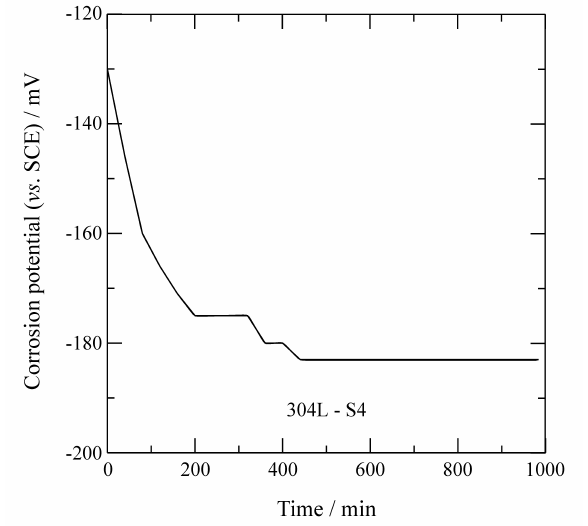
Figure 7. Corrosion potential E corr variation with immersion time in 3.5% NaCl solution for 304L steel with S4 surface finish.